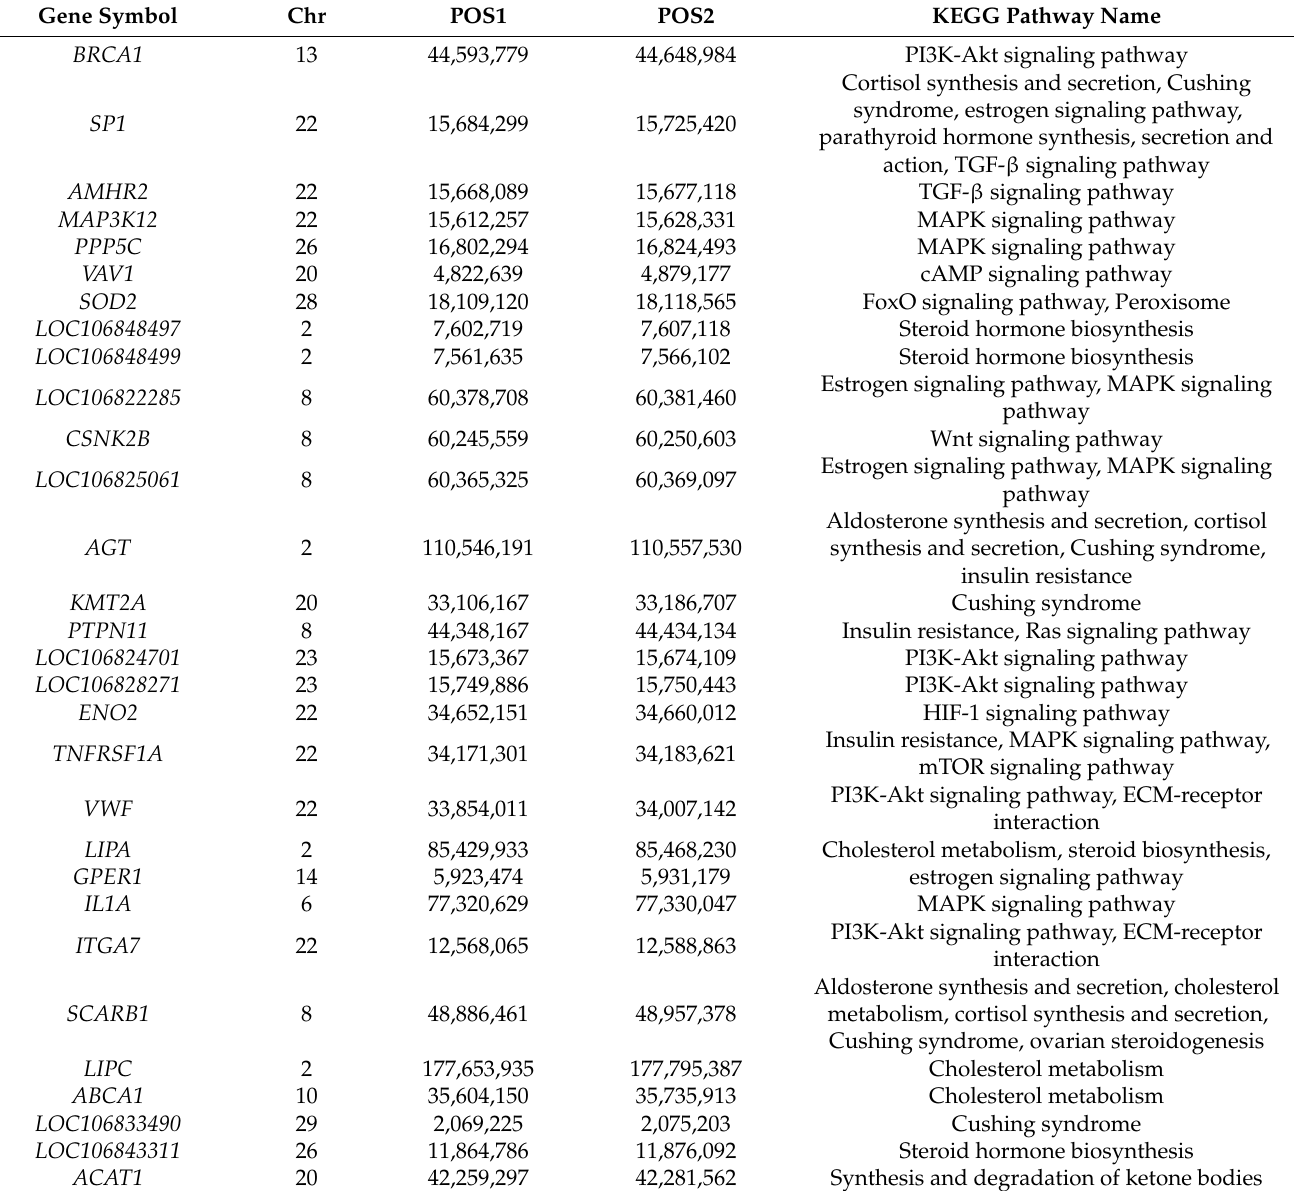
Table 2. Genes related to reproductive traits in twin colt group revealed by θπ and Tajima’s D.